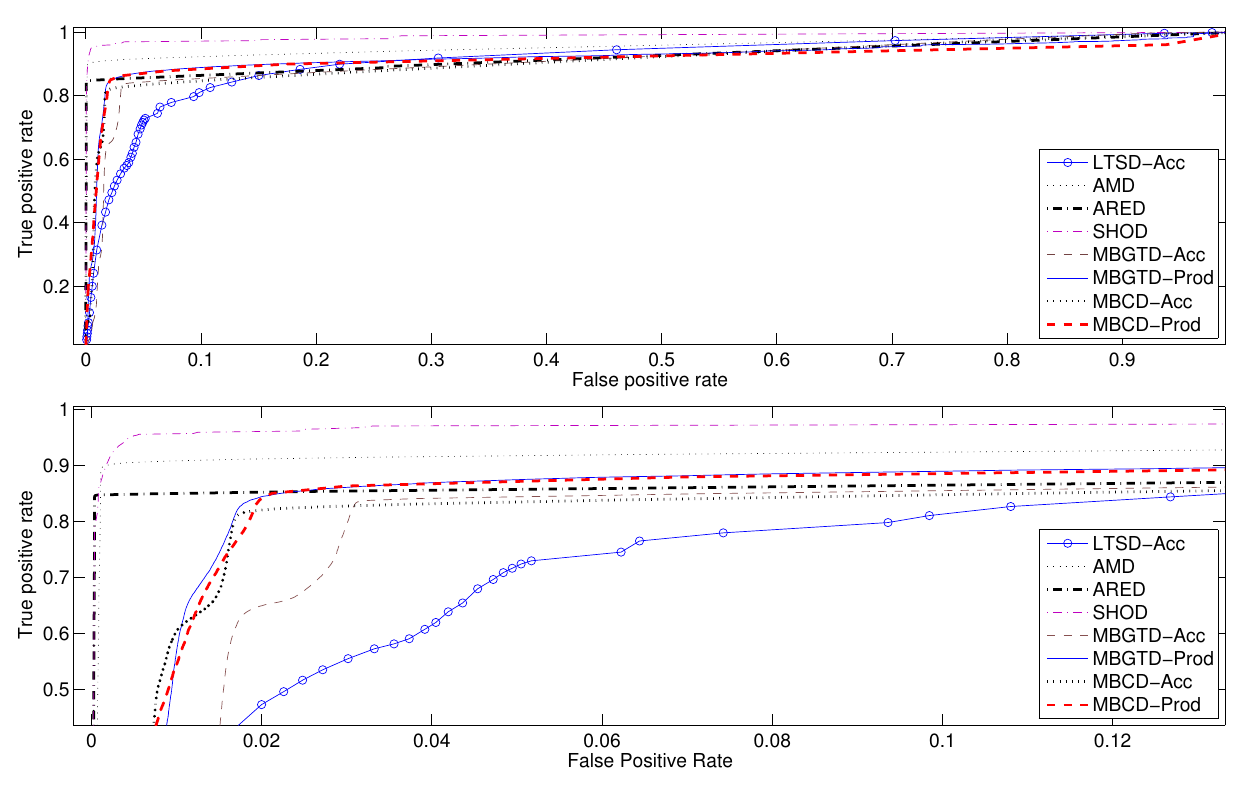
Figure 9. ROC curves computed for the eight best methods. Synthesized signals. Complete curves (up), zoomed curves (down).